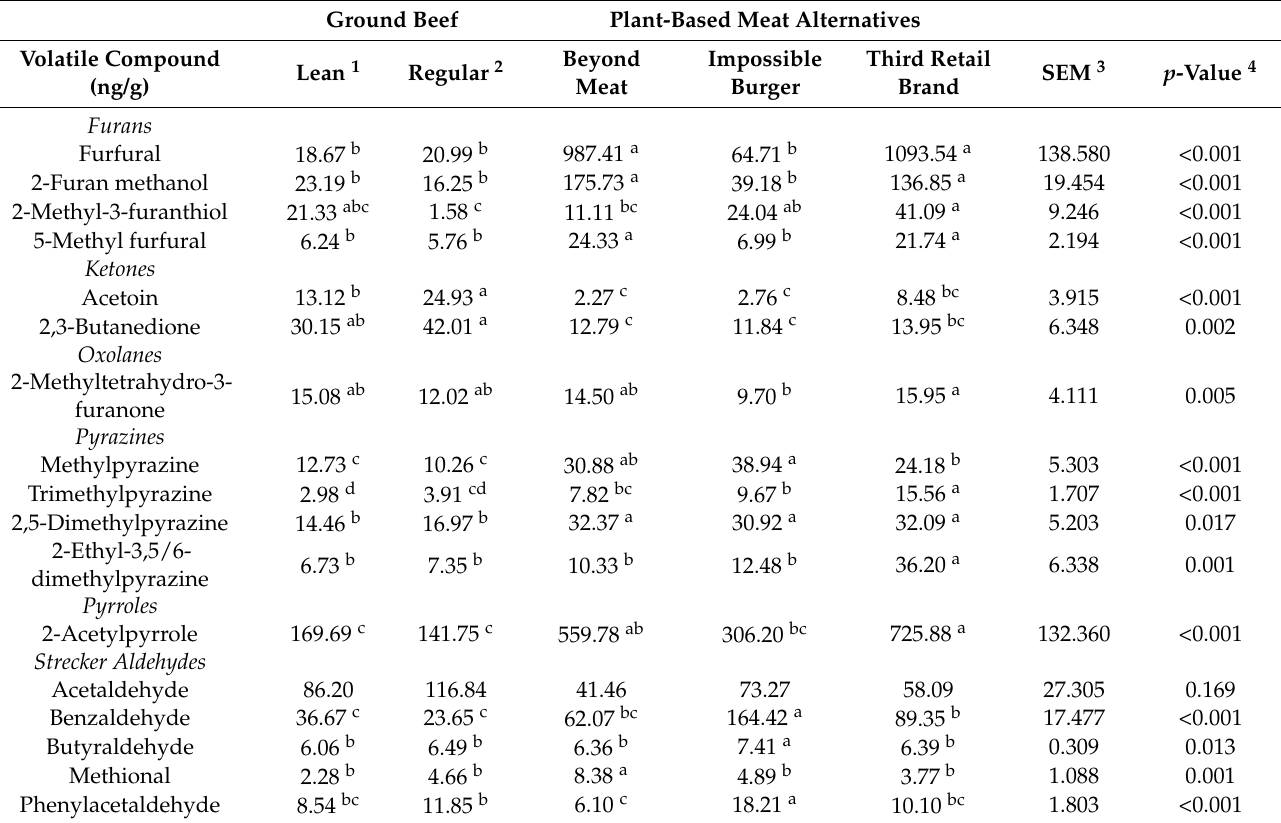
Table 3. Least squares means of Maillard reaction-derived volatile compound concentrations from three plant-based meat alternatives and two lean levels of ground